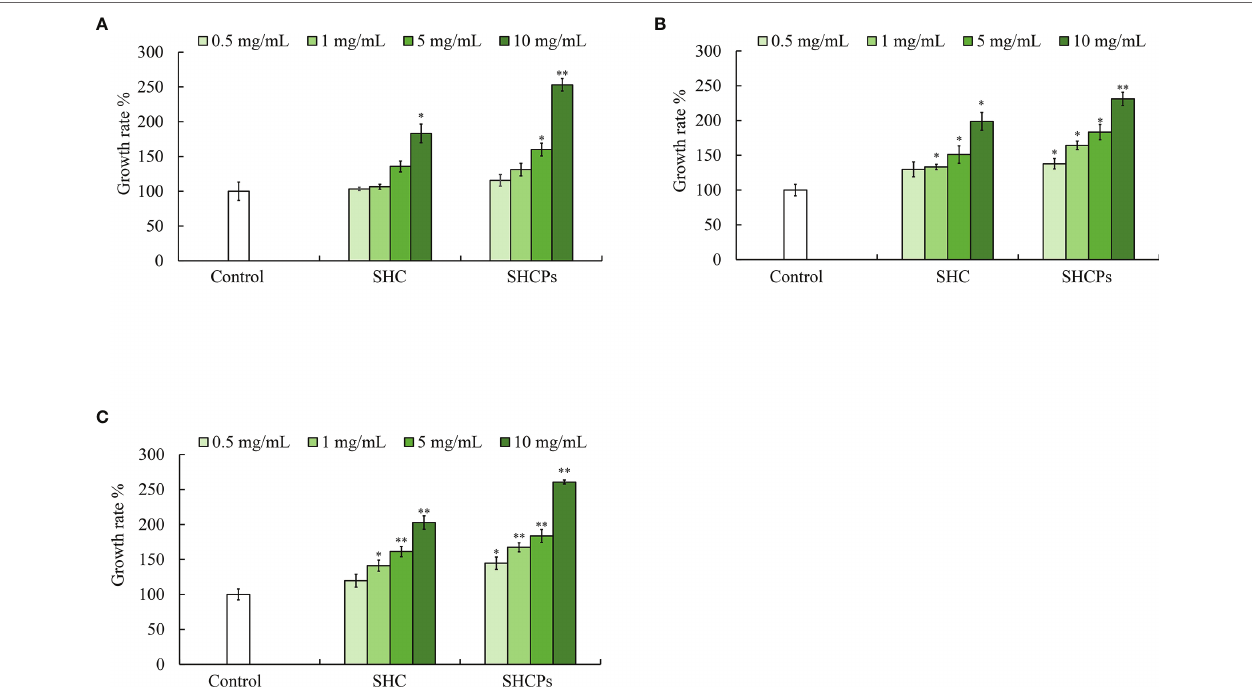
FIGURE 3 | Effect of SHC and SHCPs on probiotic bacterial growth Growth of (A) L. brevis , (B) L. pentosus and (C) L. plantarum . Experiment was triplicated and statistical evaluation was performed to compare the experimental and control groups. Values are significantly different from control group at *p<0.05, **p<0.01 (SHCPs: S. horneri crude polysaccharide extract; SHC: S. horneri Celluclast extract). The samples were treated to bacterial culture with different concentrations as 0.5,1,5 and 10 mg/mL.